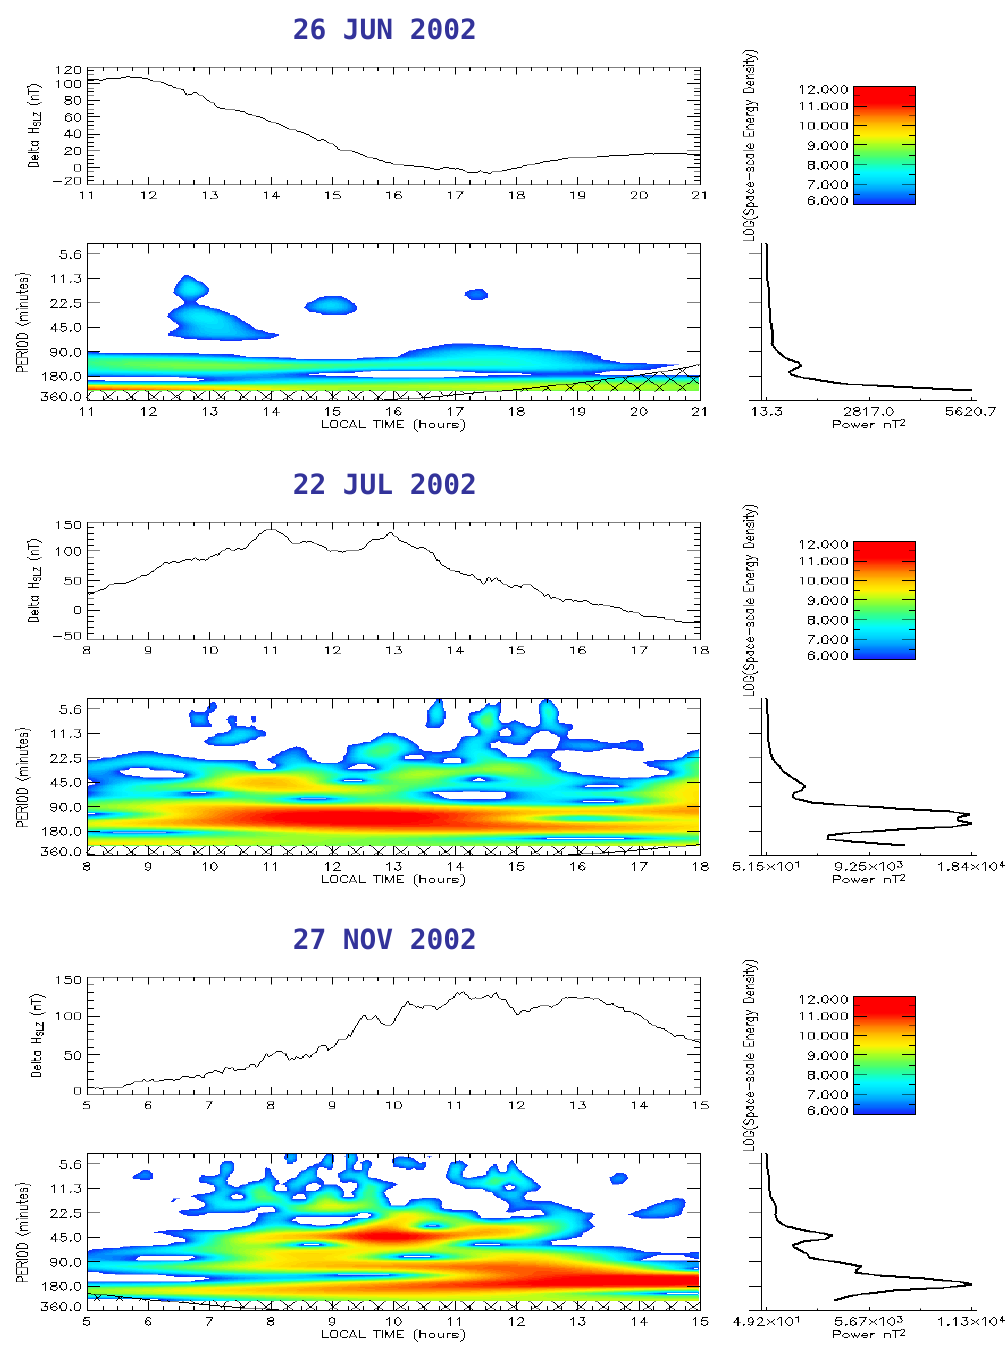
Fig. 5. Space-Scale Energy Density Map (bottom left graph) with the corresponding global wavelet spectrum (bottom right graph) and its space-scale energy density color scale (upper right graph), obtained from wavelet analysis of variations of the H component of the Earth magnetic field measured at São Luís (upper left graph) on 26 June 2002 (upper panel), on 22 July 2002 (middle panel) and on 27 November 2002 (bottom panel).